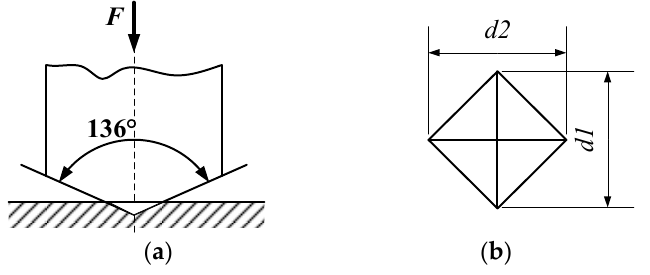
Figure 2. Indentation-based hardness test. ( a ) Pressure head; ( b ) vivtorinox hardness indentation.